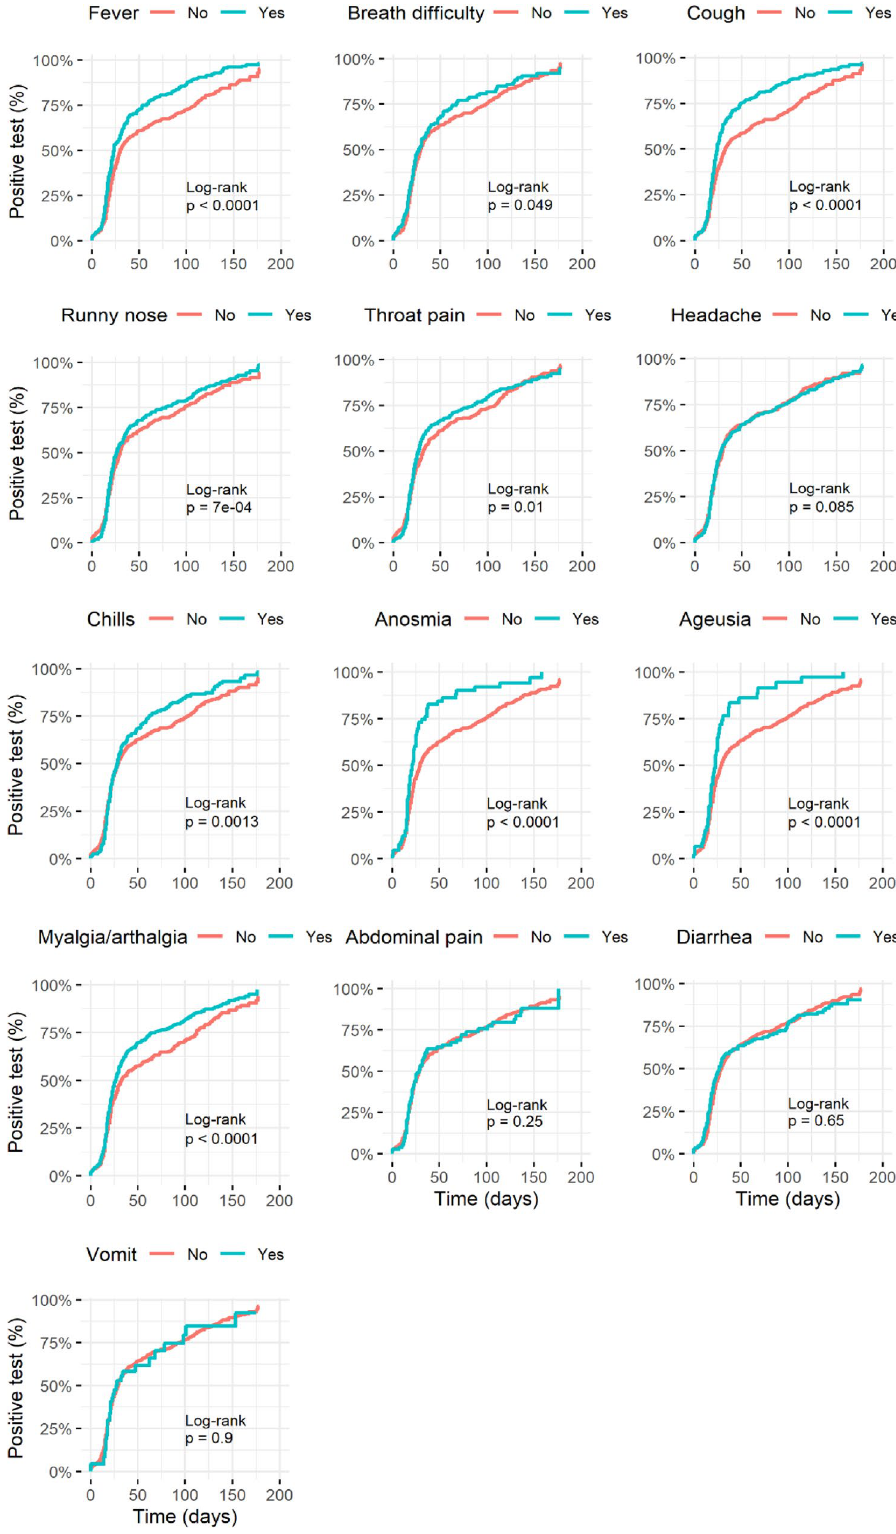
Figure 3. Seroconversion dynamic according to symptoms related to COVID-19. Kaplan–Meier curves from the time COVID-19 was diagnosed by PCR test to a positive anti-SARS-CoV-2 antibodies result. The curves present the cumulative incidence of positive antibodies test in 1100 individuals diagnosed with COVID-19 that had each symptom (blue) versus those who did not have the symptom of interest (red) in time. Presymptomatic individuals were excluded from this analysis. Statistical details are in Supplementary Table